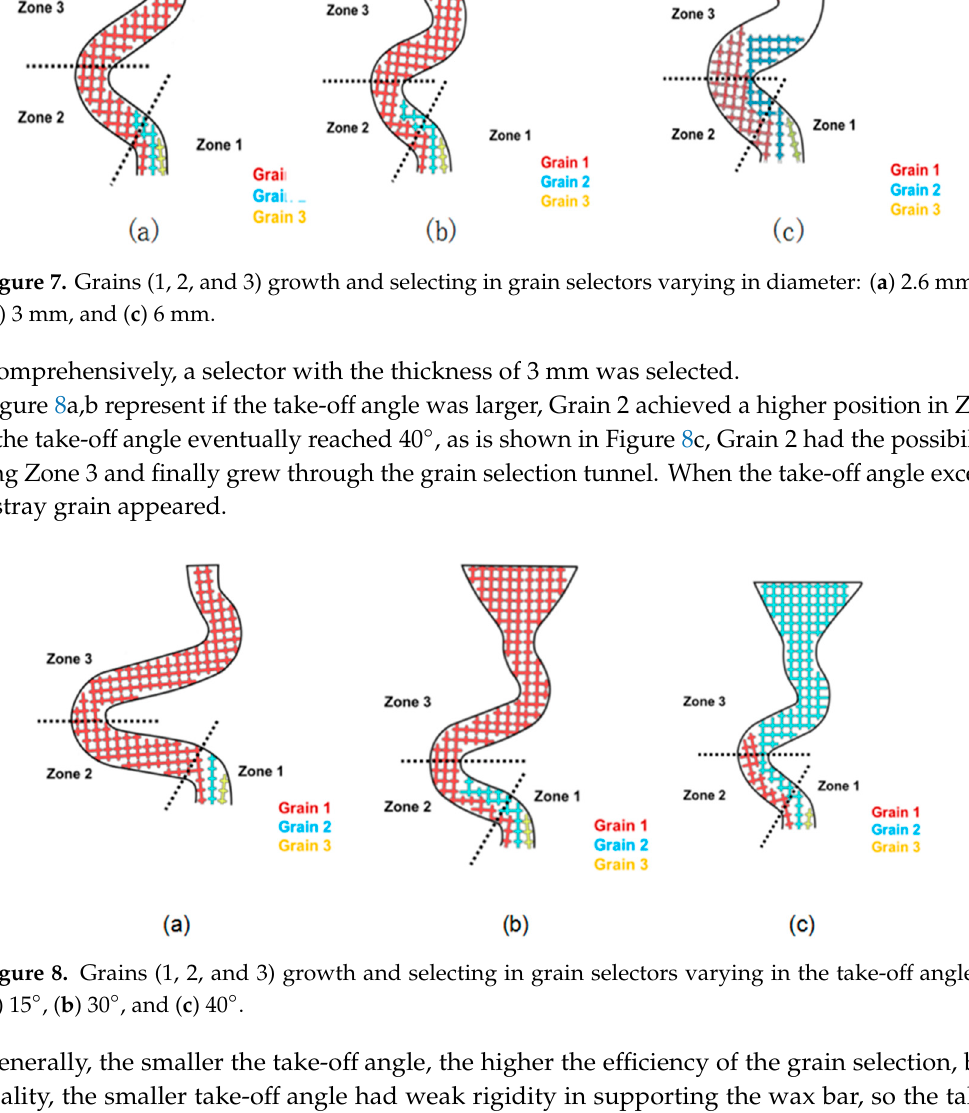
Figure 7. Grains (1, 2, and 3) growth and selecting in grain selectors varying in diameter: ( a ) 2.6 mm, ( b ) 3 mm, and ( c ) 6 mm.